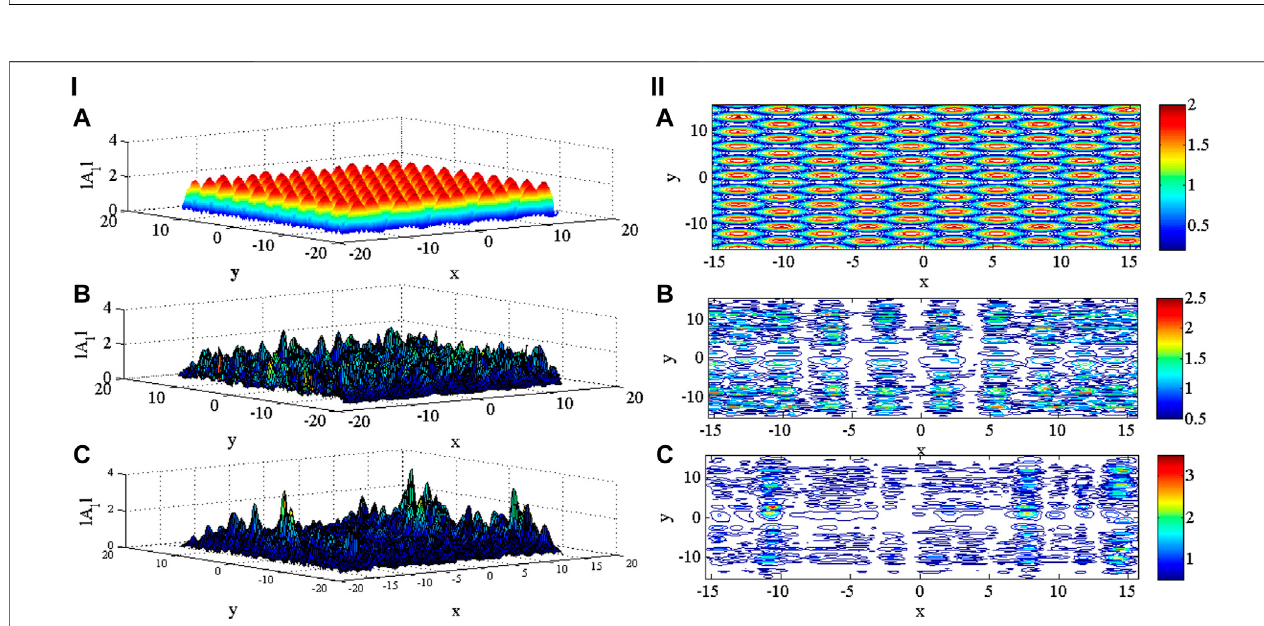
FIGURE11|(I) DAWlocalization(normalizedmagneticvectorpotential | A 1 | / A n )and (II) contourofDAW-normalizedmagneticvectorpotential (| A 1 | / A n ) inanormalized x – y plane ( x and y axis is normalized by λ i ) at three snapshots of normalized z (normalization constant z n ≈ 2/ k − ), (A) z = 0, (B) z = 4, and (C) z = 8, respectively, when only magneticislandsarepresent. “ Reproducedfrom[(Sharmaetal.,2020), PhysicsofPlasmas , 27 ,https://doi.org/10.1063/1.5142893],withthepermissionofAIPPublishing. ”